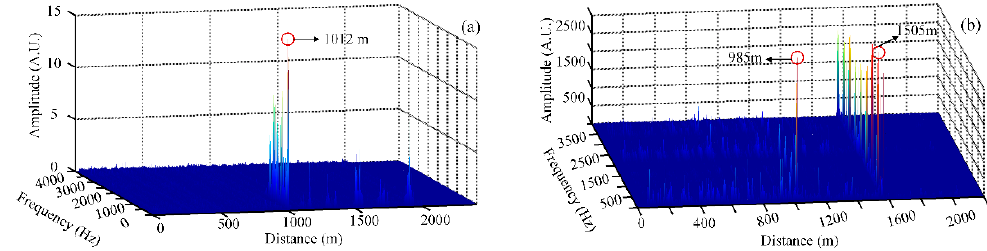
Figure 13. The obtained frequency–space map after processed with GPU: ( a ) for single-point vibration ( b ) for two-points vibration.